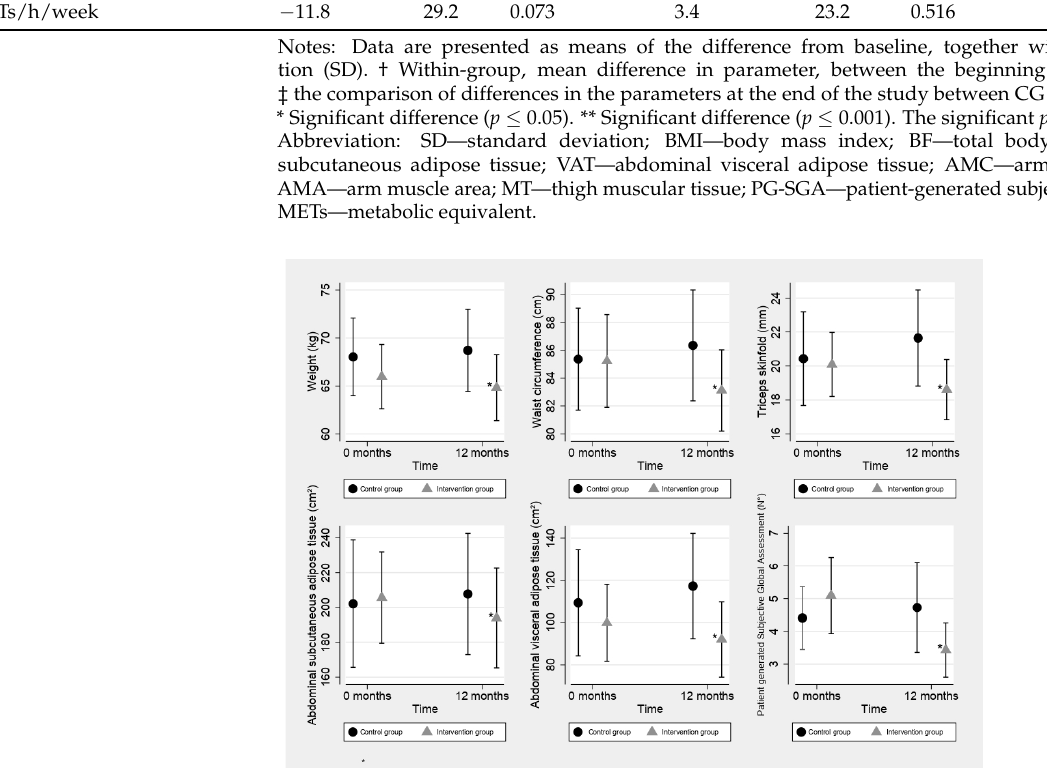
Figure 2. Changes in the body composition and nutritional status after twelve months of study. * Significant difference ( p ≤ 0.05). Each box represents the changes observed between the Control Group (Control) and Intervention Group (Intervention) from baseline. Note, that the Intervention Group significantly improved all variables of body composition, as well as the nutritional status after the training program.